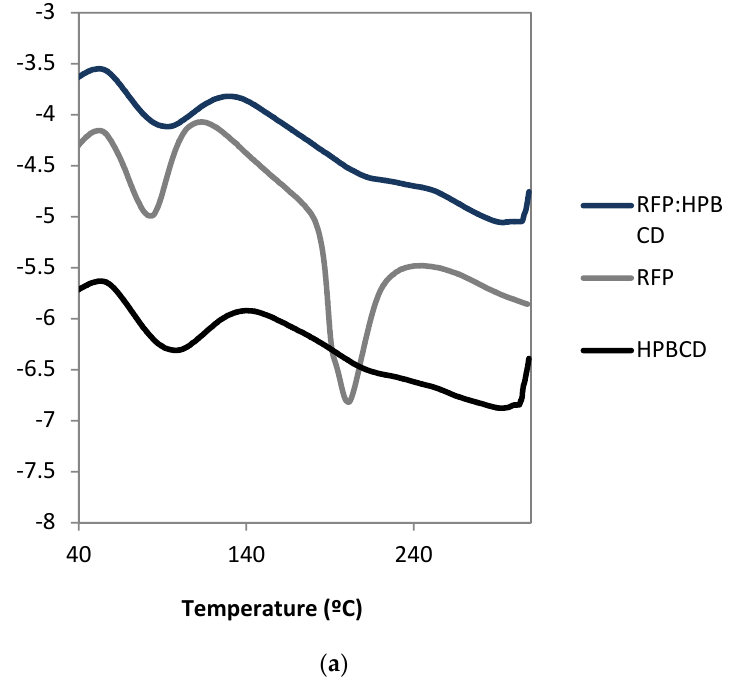
Figure 2. RFP:HPBCD solubility profile at pH 7.4 and 8.0 at 25 °C.